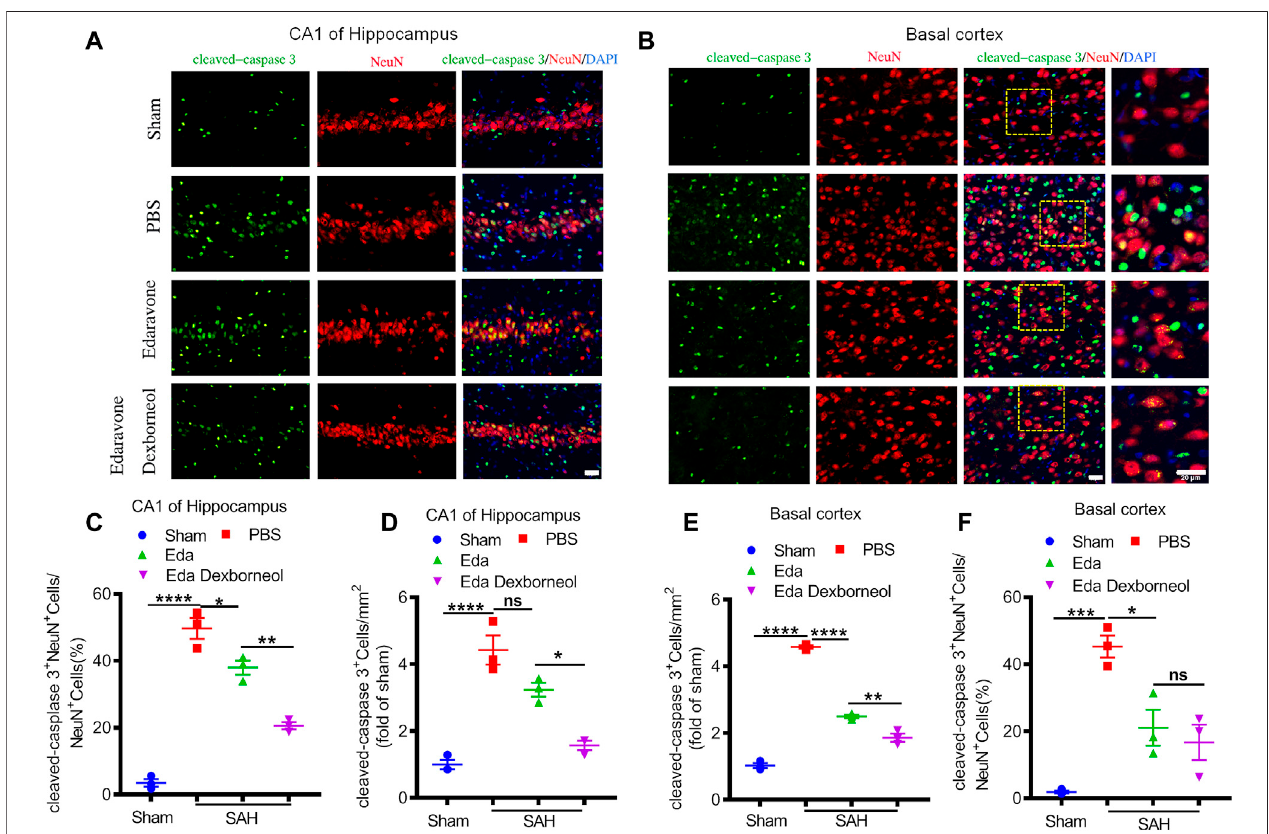
FIGURE3| Immuno fl uorescentstainingshowingthatedaravonedexborneoltreatmentprofoundlydecreasedthelevelsofcleavedcaspase3inthebrainafterSAH injury. (A,B) Representative immuno fl uorescence imagesof cleaved caspase 3 (green)/NeuN (red)-stained neurons in CA1 ofthe hippocampus (A) and basalcortex (B) at 3 d after SAH. Scale bar: 20 µm. (C – F) Quantitative analysisof caspase 3 + NeuN + neurons and cleaved caspase 3 + cells in each group. Data are normalized to sham. n = 3/group. Data are given as mean ± SE. * p < 0.05, ** p < 0.01, *** p < 0.001, **** p < 0.0001. Eda: edaravone; Eda dexborneol: edaravone